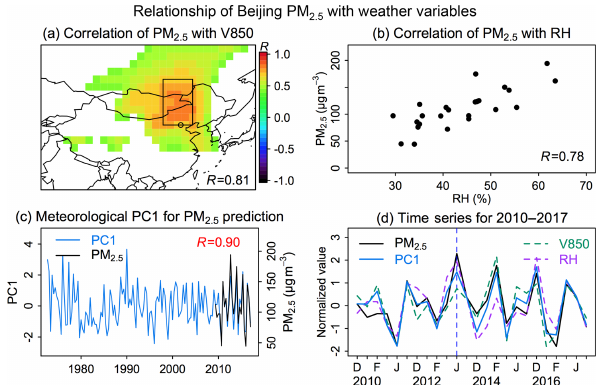
Figure 1. Relationships of wintertime monthly mean PM 2 . 5 con- centrations in Beijing (DJF 2010–2017 record) with local and re- gional meteorological variables. (a) Correlations with the 850hPa meridional wind velocity in Beijing and the surrounding region. The open circle denotes Beijing. The maximum correlation is for the rectangular box, which we use to define V850 in the text. The correlation coefficient R of monthly PM 2 . 5 and V850 in that box is shown inset. (b) Relationship with local relative humidity (RH) measured at Beijing Airport, with the correlation coefficient shown inset. (c) Time series of the first principal component (PC1) of V850 and RH for the 1973–2017 period (see Eq. 1 for definition of PC1). The time series of observed PM 2 . 5 during 2010–2017 is also shown. The correlation coefficient of PC1 and PM 2 . 5 during 2010–2017 is shown inset. (d) Monthly mean time series for 2010–2017 of PC1 and normalized PM 2 . 5 , V850, and RH, where the normalization is relative to the 2010–2017